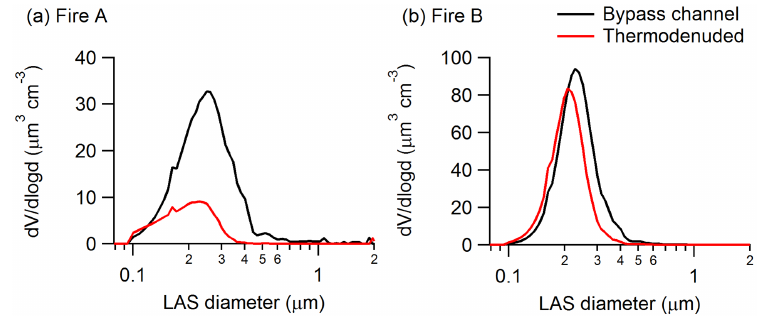
Figure 5. LAS volume size distribution for (a) Fire A and (b) Fire B showing average over one cycle of bypass channel (black) and after thermodenuder